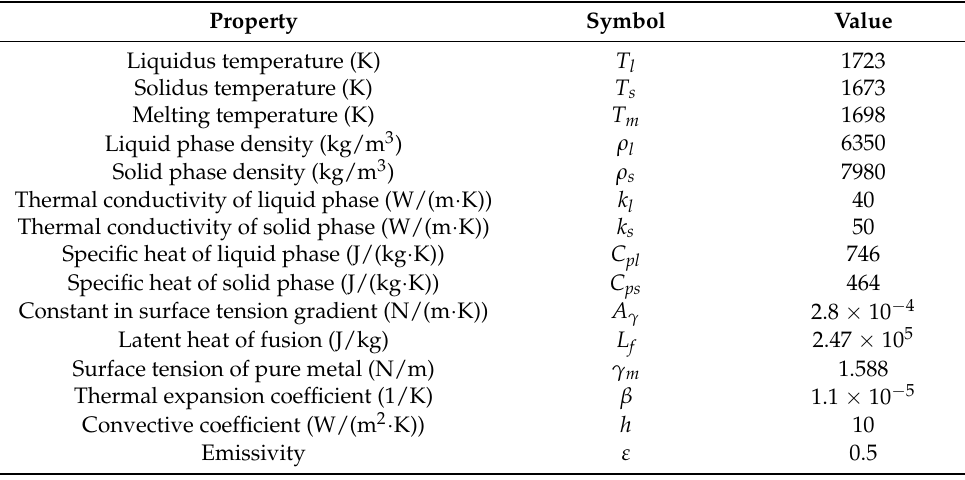
Table 2. Physical properties of 316L stainless steel